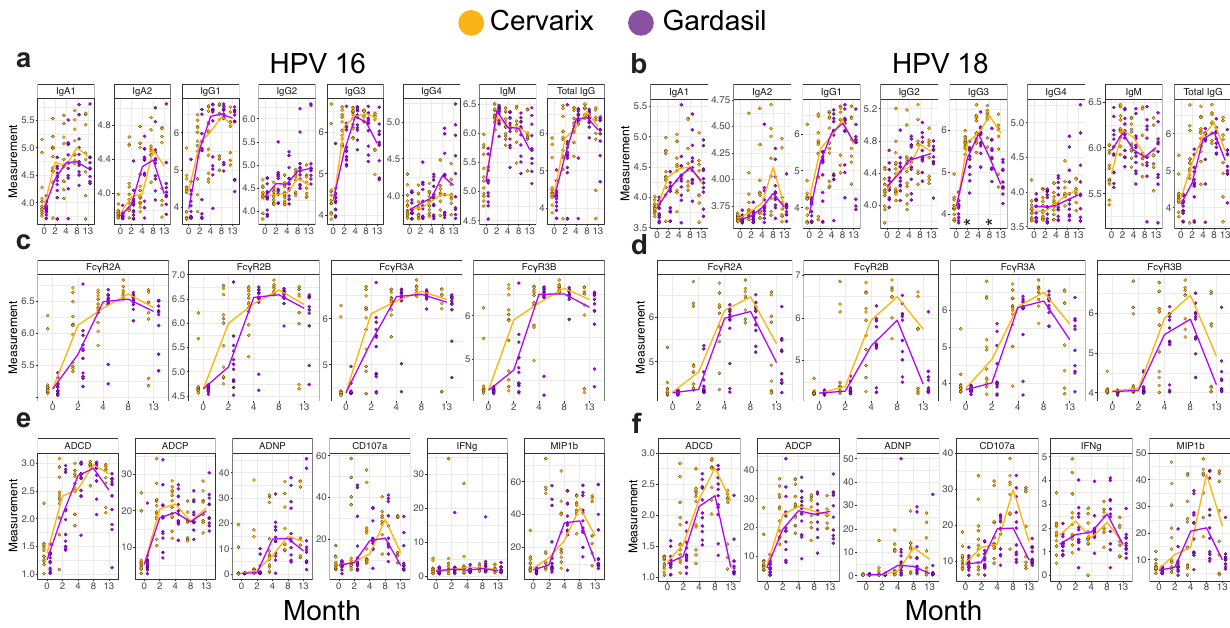
Fig. 2 Overall response to vaccination over time. a – f Univariate plots showing levels of antibody titers ( a , b ), FcR binding ( c , d ), and Fc- effector functions ( e , f ). Fc-effector functions include antibody-dependent complement deposition (ADCD), antibody-dependent cellular phagocytosis (ADCP), antibody-dependent neutrophil phagocytosis (ADNP), and percentage of CD107a (CD107a), MIP-1 β (MIP1b), and Interferon gamma (IFNg) positive cells. Measurement for each patient is denoted by dots across timepoints with running median for Cervarix ® (orange) and Gardasil ® (purple) against HPV16 ( a , c , e ) and HPV18 ( b , d , f ). Log10 of mean fl uorescent intensity is used as a unit of measurement for antibody titers, FcR binding, and ADCD, whereas phagocytic score was used for ADCP and ADNP. For CD107a, MIP1b, IFNg, percentage of positive cells was used as a unit of measurement. Two-sided Wilcoxon rank-sum test was performed between the two vaccine groups. * indicates p < 0.05 after multiple-test correction using the Benjamini-Hochberg procedure for all comparisons shown in the fi